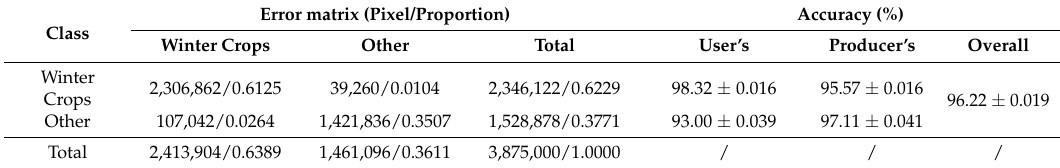
Table 2. Results of accuracy validation for the composite image